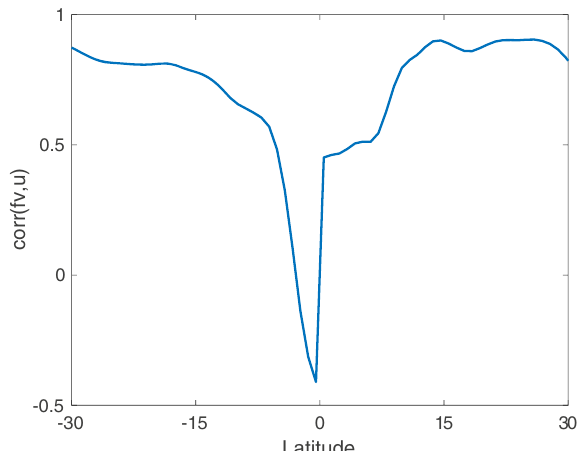
Fig. 4 Linking low-level meridional and zonal winds. Correlation of near-surface Coriolis force on the mean meridional wind ( fv ) and the mean zonal wind ( u ) as a function of